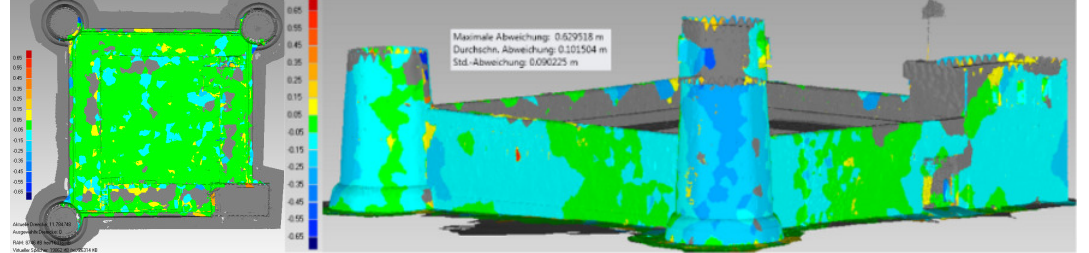
Figure 13: 3D data in comparison – 3D model from laser scanning (IMAGER 5006h) vs. 3D model of the interior area (left) & 3D model of the exterior walls (right) from 123D Catch Beta (green = ±5cm)